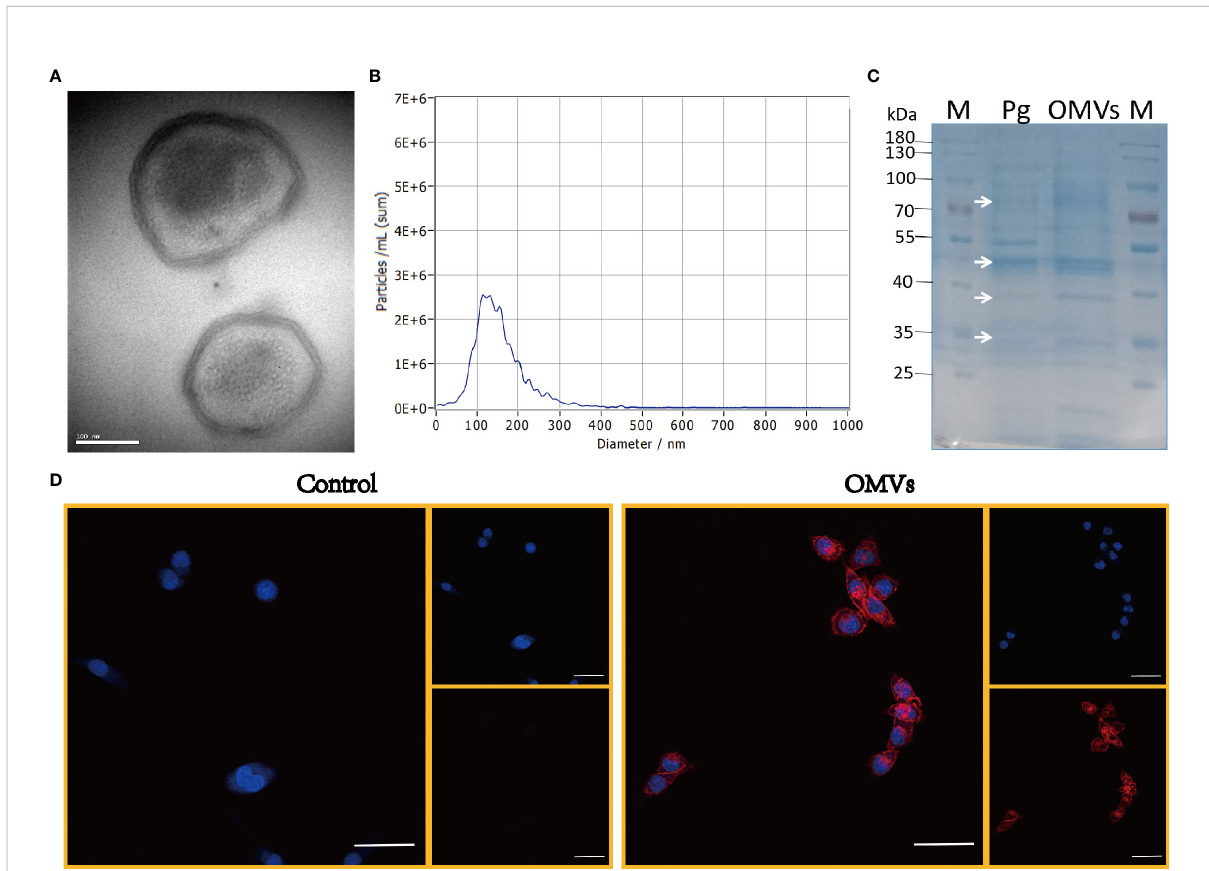
FIGURE 1 Characterization of Pg OMVs. (A) Pg OMVs observed by TEM. Scale bar = 100 nm. (B) NTA measured the diameter of Pg OMVs. (C) SDS-PAGE gel showed cargo proteins of Pg OMVs. White arrows indicate the bands in Pg OMVs samples (Pg OMVs) that correspond to Pg bacterial cell proteins (Pg). (D) Confocal images of Pg OMVs uptake by BV2 cells within 30 minutes, Nuclei (blue) were labeled with DAPI, Pg OMVs or PBS were labeled with PKH26 (red). Scale bar = 50 m m. TEM, transmission electron microscopy; NTA, nanoparticle-tracking